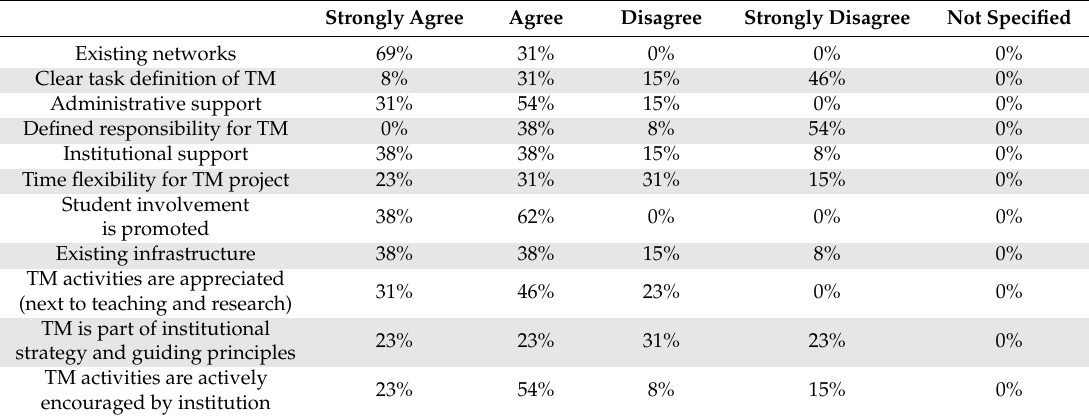
Table 1. Positive impact factors on third mission (TM) activities.